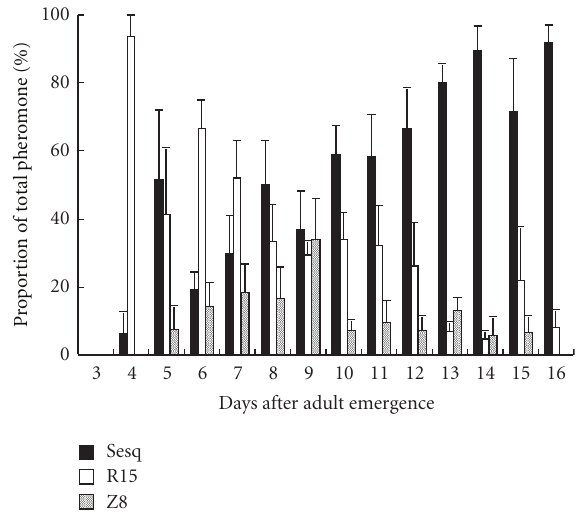
Figure 2: Proportions of each pheromone component of Piezodorus hybneri males in relation to adult age. Sesq: β -sesquiphellandrene; R15: ( R )-15-hexadecanolide; Z8: methyl ( Z )-8-hexadecenoate. Ver- tical lines represent